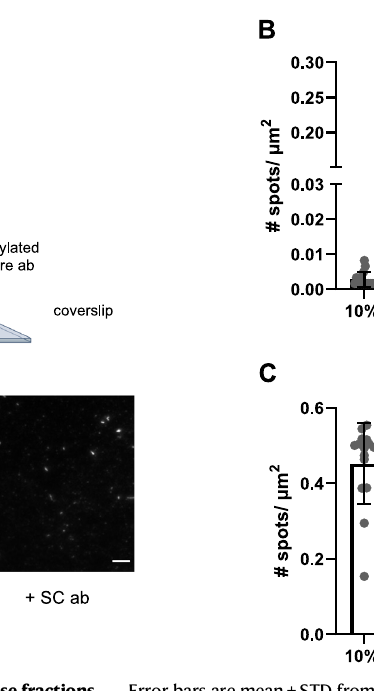
Error bars are mean±STD from 15 different fi elds of view. Each individual point is representing one fi eld of view. C Number of detected aggregates in each species using the sequence-speci fi c SC epitope-speci fi c antibody targeting amino acids 121 – 125. Error bars are mean±STD from 15 different fi elds of view. Each individual point is representing one fi eld of view. One representative replicate out of three is displayed here. Each individual colour is representing a distinct sucrose fraction (grey=10%, orange=20%, green=30%, blue=40%, violet=50%). Source data are provided as a Source Data fi le. MJF=MJFR-14-6-4-2 antibody, SC=Santa cCruz 211 antibody, μ m=Micrometer,#=Number.Detailsabouttheantibodiescanbefound in Supplementary Table